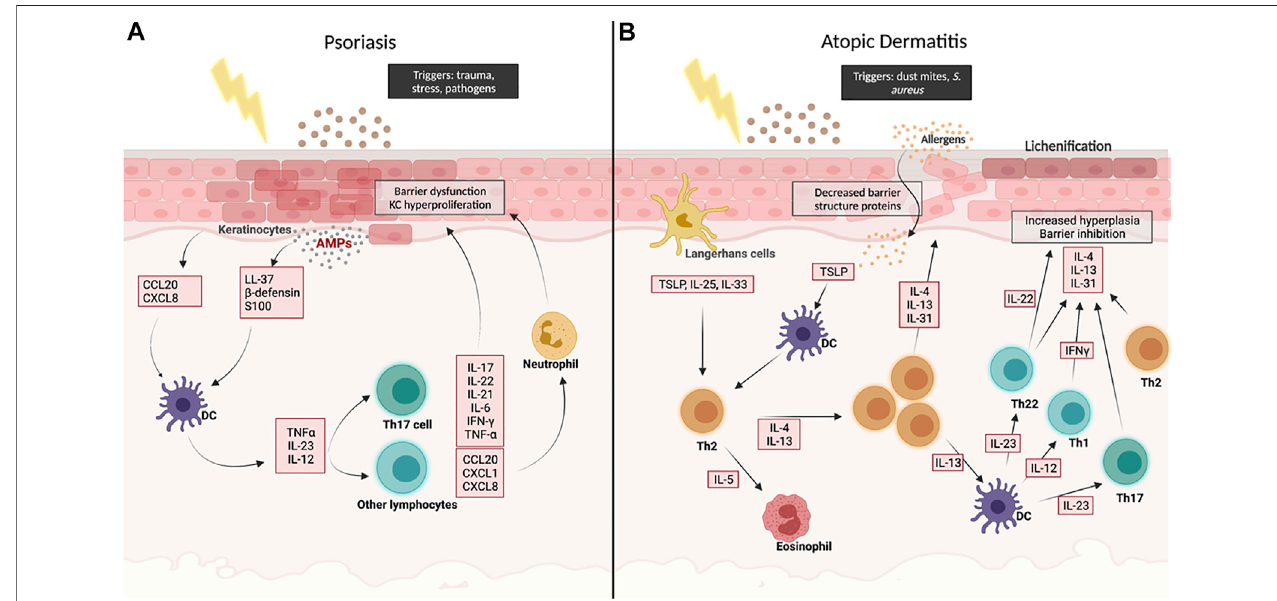
FIGURE2| Aschematicoverviewofthe invitro modelsthathavebeenappliedtorecapitulatetheimmunologicalfunctionsoftheskinandtomodelin fl ammatoryskindiseases. (A) shows the 2 different types of 2D models; (B) shows the HSE and RHE types of 3D models and (C) shows the concept of Skin-on-a-chip. Created with BioRender.com.